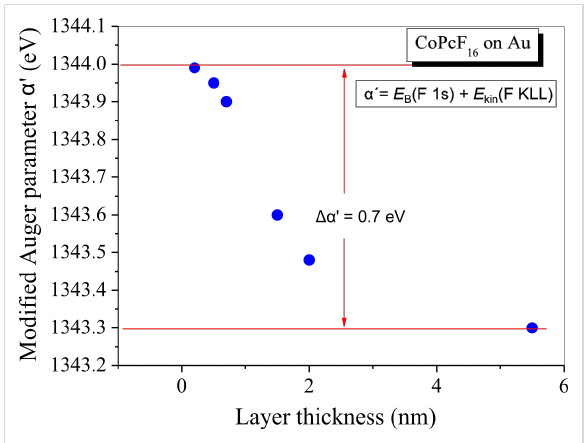
Figure 3: CoPcF 16 on polycrystalline Au: Modified Auger parameter α ’ for fluorine.